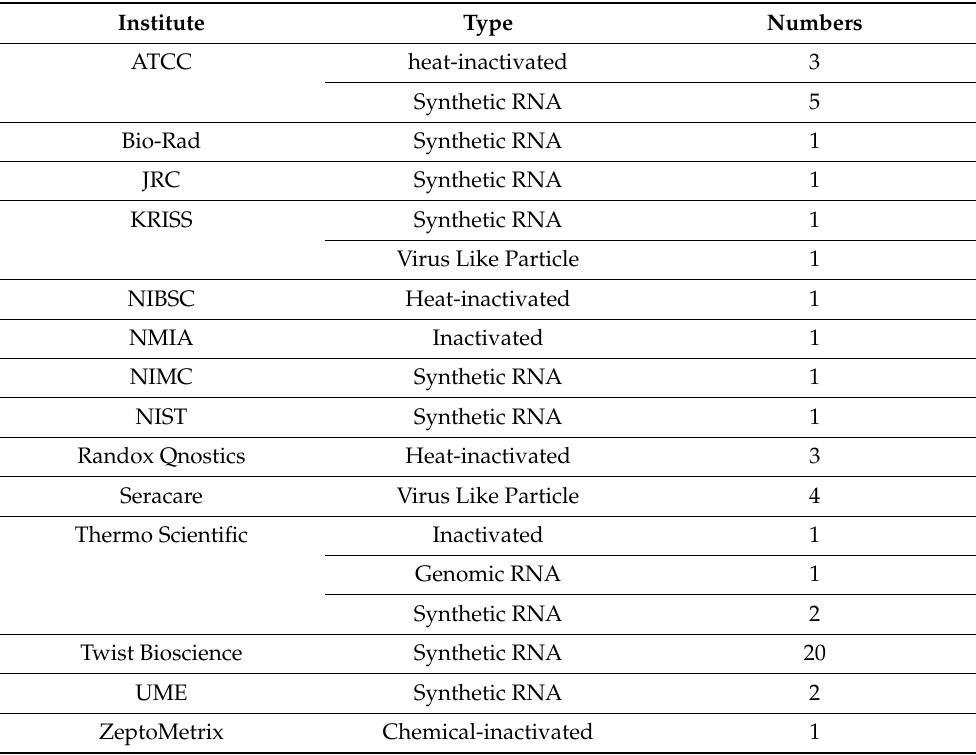
Table 4. Reference materials and resources for SARS-CoV-2 nucleic acid